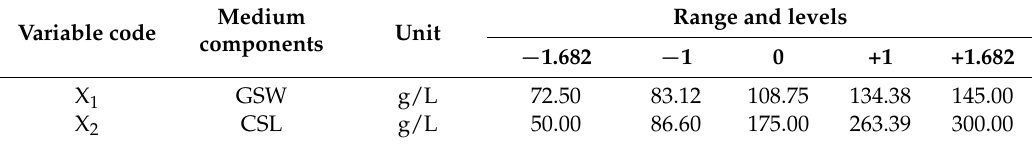
Table 1. Central composite design (CCD) experimental ranges and levels of the independent variables. Variable